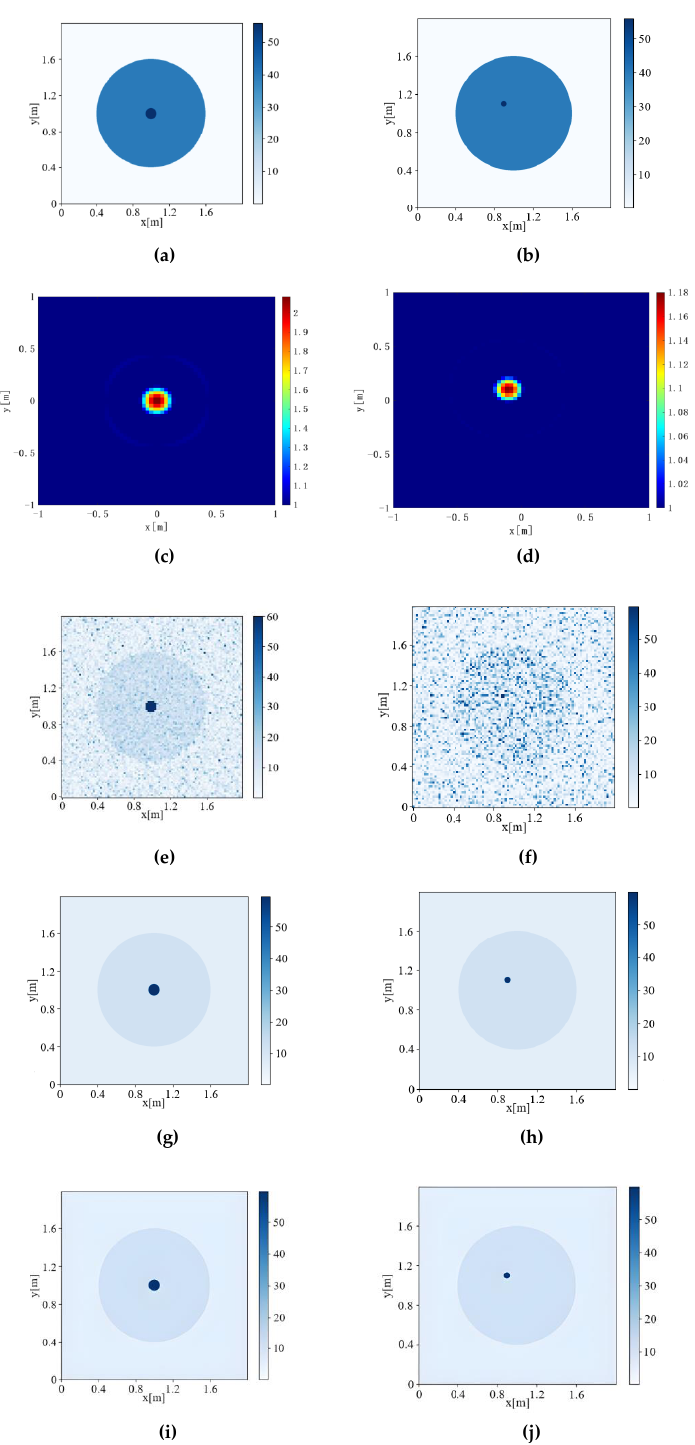
Figure 7. Inversion results of the Inversion Ratio from 1:10 to 1:20. ( a ) Model diagram of 𝐼𝑛𝑣𝑒𝑟𝑠𝑖𝑜𝑛 𝑅𝑎𝑡𝑖𝑜 = 1:10, ( b ) model diagram of 𝐼𝑛𝑣𝑒𝑟𝑠𝑖𝑜𝑛 𝑅𝑎𝑡𝑖𝑜 = 1:20, ( c ) Contrast Source Inversion results of 𝐼𝑛𝑣𝑒𝑟𝑠𝑖𝑜𝑛 𝑅𝑎𝑡𝑖𝑜 = 1:10, ( d ) Contrast Source Inversion results of 𝐼𝑛𝑣𝑒𝑟𝑠𝑖𝑜𝑛 𝑅𝑎𝑡𝑖𝑜 = 1:20, ( e ) Deep Convolutional Inversion results of 𝐼𝑛𝑣𝑒𝑟𝑠𝑖𝑜𝑛 𝑅𝑎𝑡𝑖𝑜 = 1:10, ( f ) Deep Convolutional Inver- sion results of 𝐼𝑛𝑣𝑒𝑟𝑠𝑖𝑜𝑛 𝑅𝑎𝑡𝑖𝑜 = 1:20, ( g ) joint-Driven inversion results of 𝐼𝑛𝑣𝑒𝑟𝑠𝑖𝑜𝑛 𝑅𝑎𝑡𝑖𝑜 = 1:10, ( h ) joint-Driven inversion results of 𝐼𝑛𝑣𝑒𝑟𝑠𝑖𝑜𝑛 𝑅𝑎𝑡𝑖𝑜 = 1:20, ( i ) Joint-Driven super-resolution inver- sion results of 𝐼𝑛𝑣𝑒𝑟𝑠𝑖𝑜𝑛 𝑅𝑎𝑡𝑖𝑜 = 1:10, and ( j ) Joint-Driven super-resolution inversion results of 𝐼𝑛𝑣𝑒𝑟𝑠𝑖𝑜𝑛 𝑅𝑎𝑡𝑖𝑜 = 1:20.